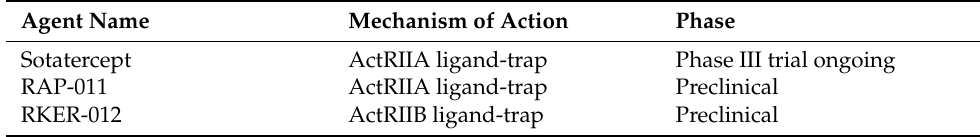
Table 3. Current therapeutic options targeting activin